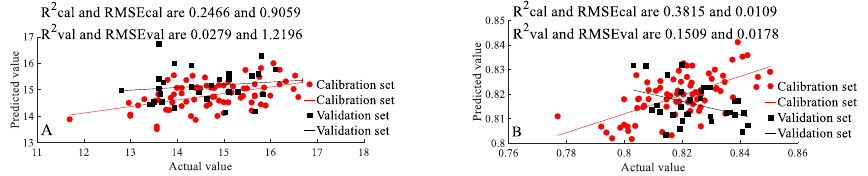
Figure 4. TSSC and water content detection based on electronic nose. ( A ) TSSC detection, ( B ) water content detection.